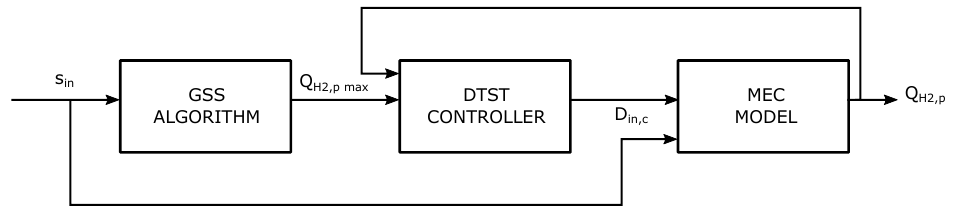
Figure 3. Optimization scheme of the